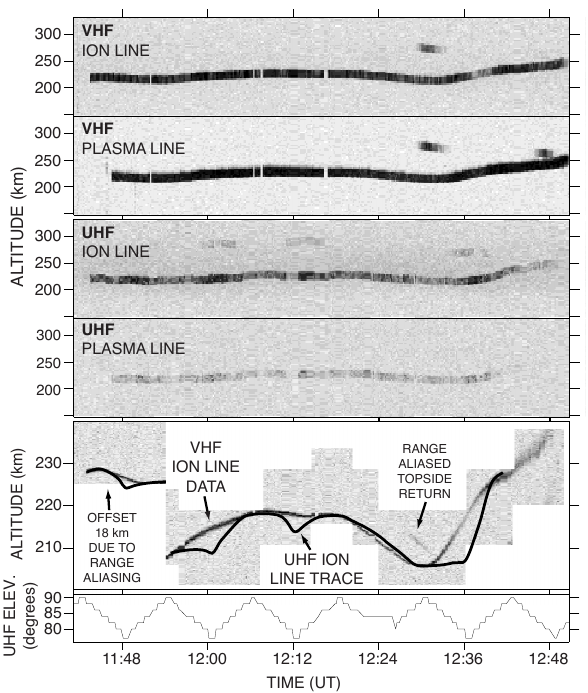
Fig. 1. Schematic view of HF ray paths in the bottomside F re- gion for f o F2 >f hf + f ce , where f o F2 is the peak F-region plasma frequency (the maximum O-mode reflection frequency), f hf is the HF, or RF, pump frequency, and f ce is the electron cyclotron, or gyro-, frequency. X =( f pe / f hf ) 2 and Y = f ce / f hf , where f pe is the cold electron plasma frequency. The Spitze angle is equal to arcsin[( Y /(1+ Y )] 1 / 2 sin θ B ] , where θ B is the angle of the geomag- netic field and where both angles are with respect to geographic zenith, as shown in the figure. The radar matching height is given by X =[ 1 − (Y sin θ B ) 2 ] / [ 1 + 3 (kλ D ) 2 ] , where λ D = v e / 2 πf pe is the Debye length with v e = (k B T e /m e ) the electron thermal speed, k B the Boltzmann constant, T e electron temperature, and m e electron mass. Adapted from Rietveld et al. (1993), Fig. 4.